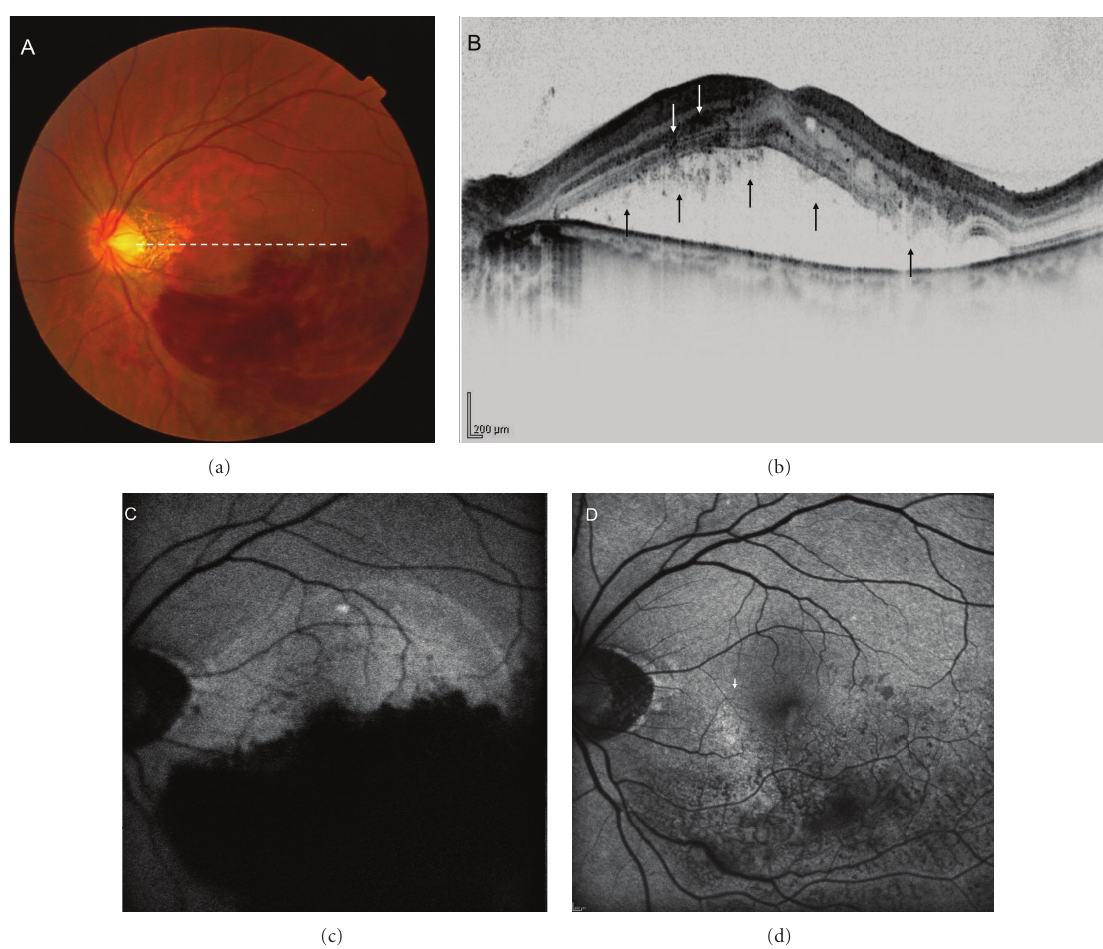
Figure 3: Fundus photograph, OCT, and autofluorescence images for Patient 3 (a 56-year-old man). Color fundus photography at the first visit showed a lower temporal vein occlusion in the left eye (A). The dashed line indicates the OCT scanning line. The OCT image (B) showed widespread deposits on the outer surface of the retina (black arrows). An intraretinal deposit was observed in the outer plexiform layer of the retina (white arrow). Fundus autofluorescence (C) at the first visit showed di ff use hyperautofluorescence in the area of serous retinal detachment. The eye was treated with an intravitreal bevacizumab injection. After the serous retinal detachment was resolved, fundus autofluorescence (D) showed hyperautofluorescence in the nasal area of the fovea (arrowhead). The best-corrected visual acuity in the patient’s left eye was 0.7 at the final